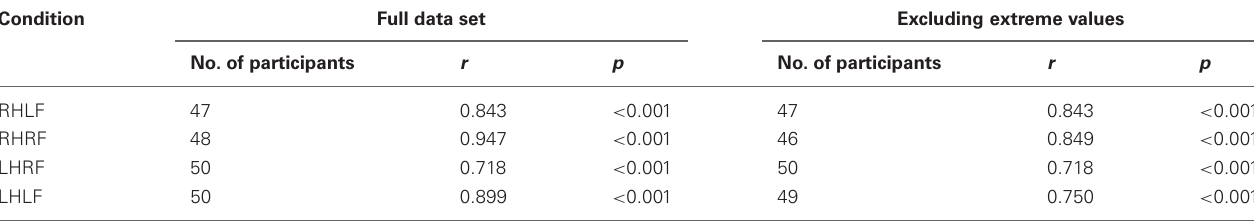
Table 5 | Results for the inter-rater reliability. Condition